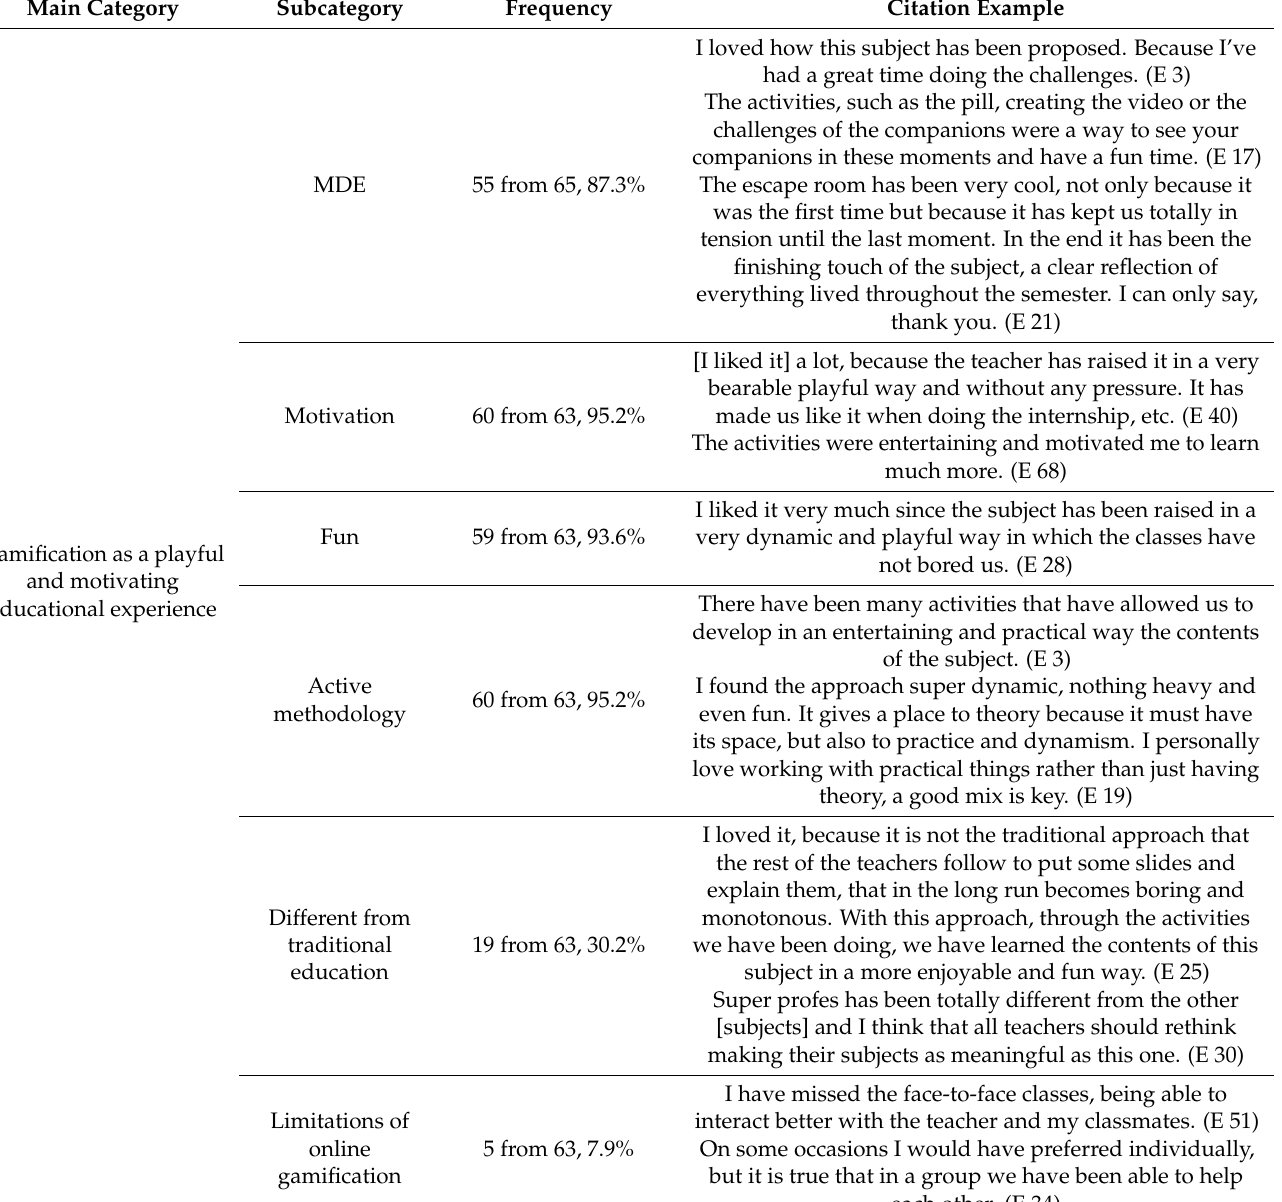
Table 2. Results of main category